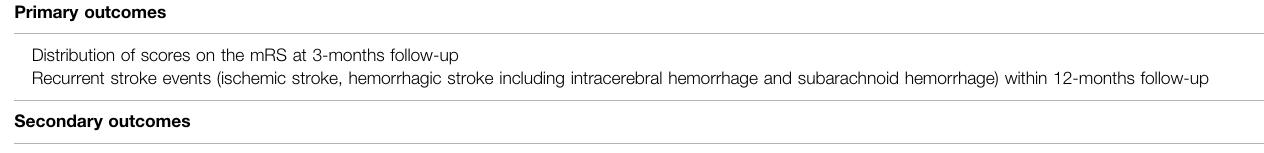
TABLE 2 | The complete outcomes of CASES-TCM study.